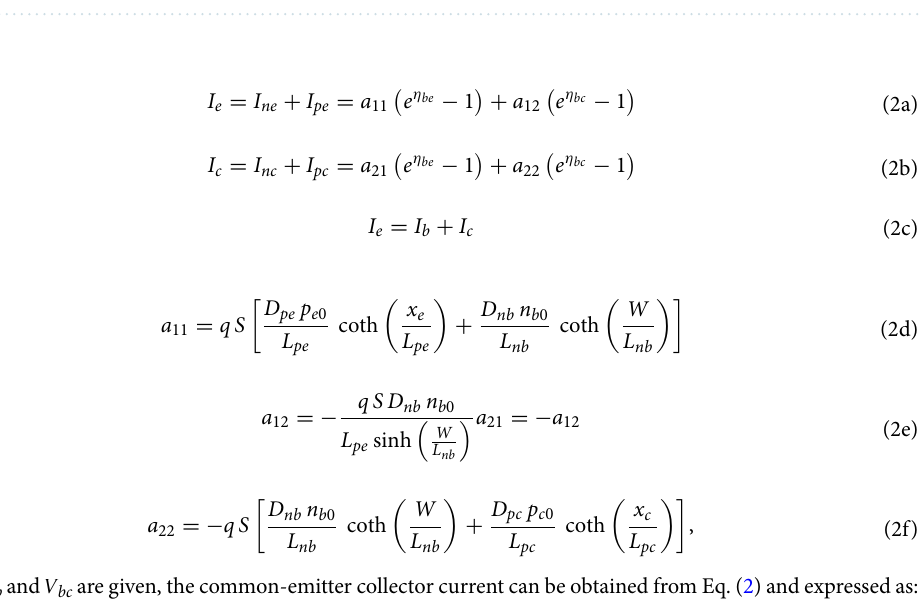
Figure 4. ( a ) Schematics of the new thermocouple design including a p -type and an n -type thermoelectric legs, conductor strips at the hot end and the cold ends and a electrical load resistance, R L . An n - p - n bipolar junction resistor (not to scale) is joined with the n -type leg at the exterior surface and a p - n - p BJT is joined with the p -type leg. These two BJTs are common-emitter configured. V be is the bias between the base and the emitter. V ce is the bias between the collector and the emitter. R nc and R pc are the load resistance for the n - p - n and p - n - p transistors, respectively. ( b ) Symbols of an n - p - n transistor. ( c ) Symbols of a p - n - p